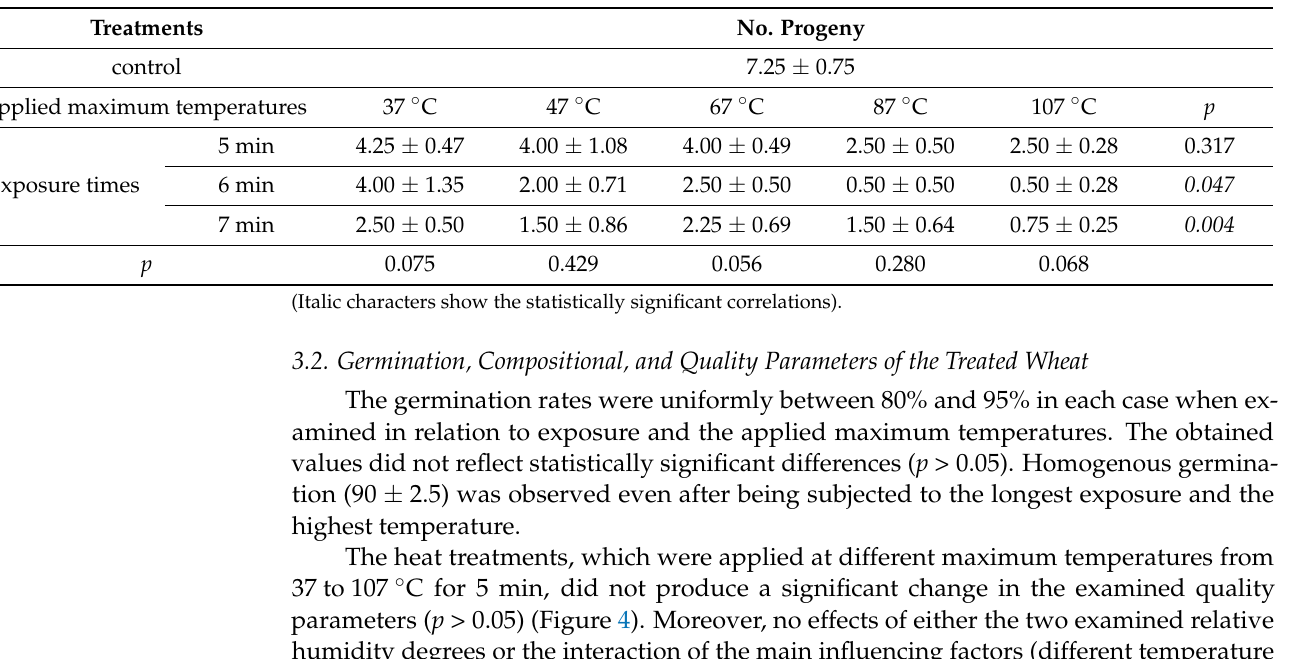
Table 1. Progeny production of S. granarius (mean number of dead adults ± SE) in heated wheat 45 days after the removal of exposed S. granarius adults, and the statistical relationships ( p ≤ 0.05).